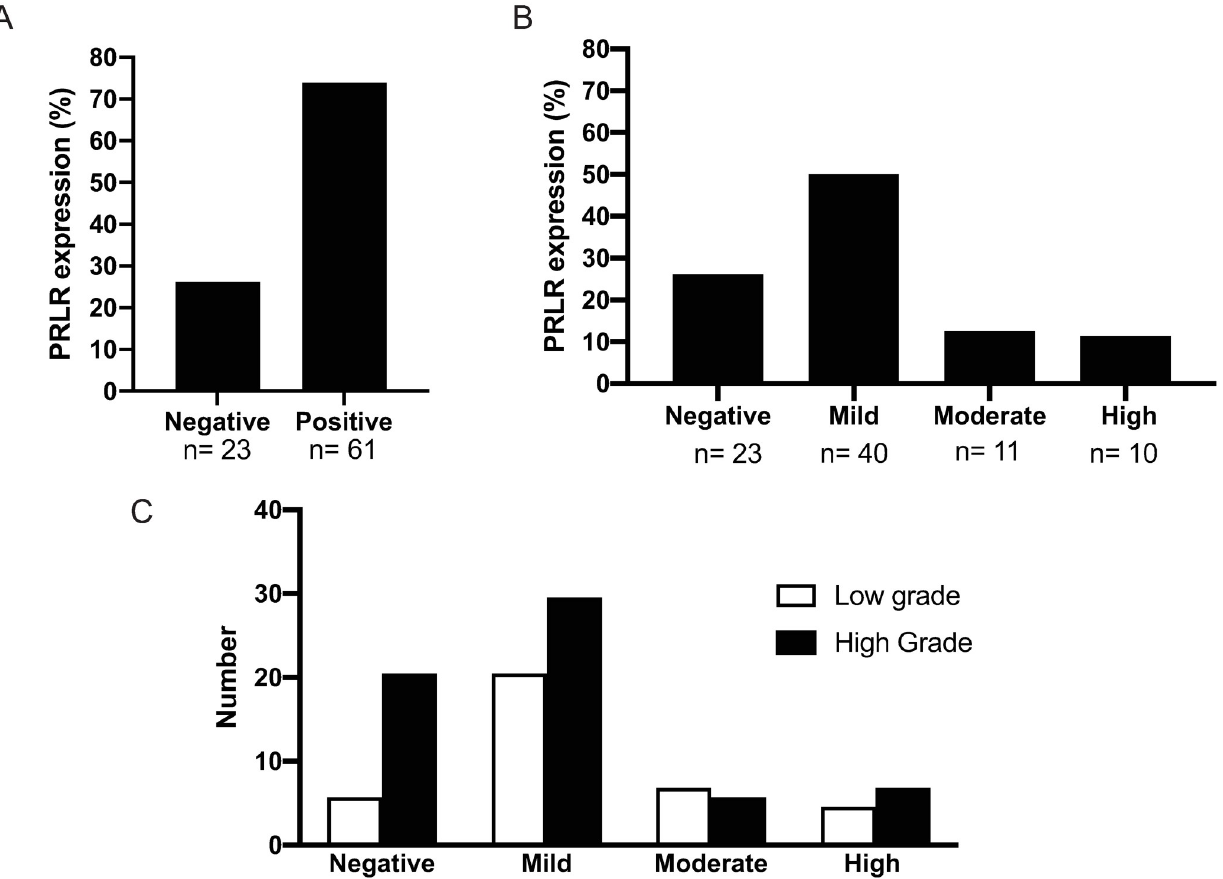
Fig 3. Prolactin receptor immuno-reactivity in ovarian cancer tissues. Histological analyses of a tissue microarray (TMA) with 84 ovarian cancer (OC) and normal ovarian tissues as a control. A) PRLR immuno reactivity was detected in 61 out of 84 OC patients (72%) while 23 patients were negative (27%). B) PRLR staining in OC tissues; a mild level of PRLR staining ( < 25% of cells) was detected in 44 out of 84 patients (50%), a moderate level (25–50% of cells) was found in 11 patients (12%) and a high level ( > 50% of cells) was fond in 10 patients (11%). C) Percentages of PRLR positive cells were also shown in OC patients with moderate and high-grade tumour. Mild PRLR staining was detected in 30% of high-grade tumors and 20% of low-grade tumors, moderate level in 6% of high-grade tumors and 7% of low-grade tumors and high-level staining level was found in 7% of high-grade tumors and 5% of low-grade tumors. All percentages were obtained by two independent pathologist and presented with 95% confidence